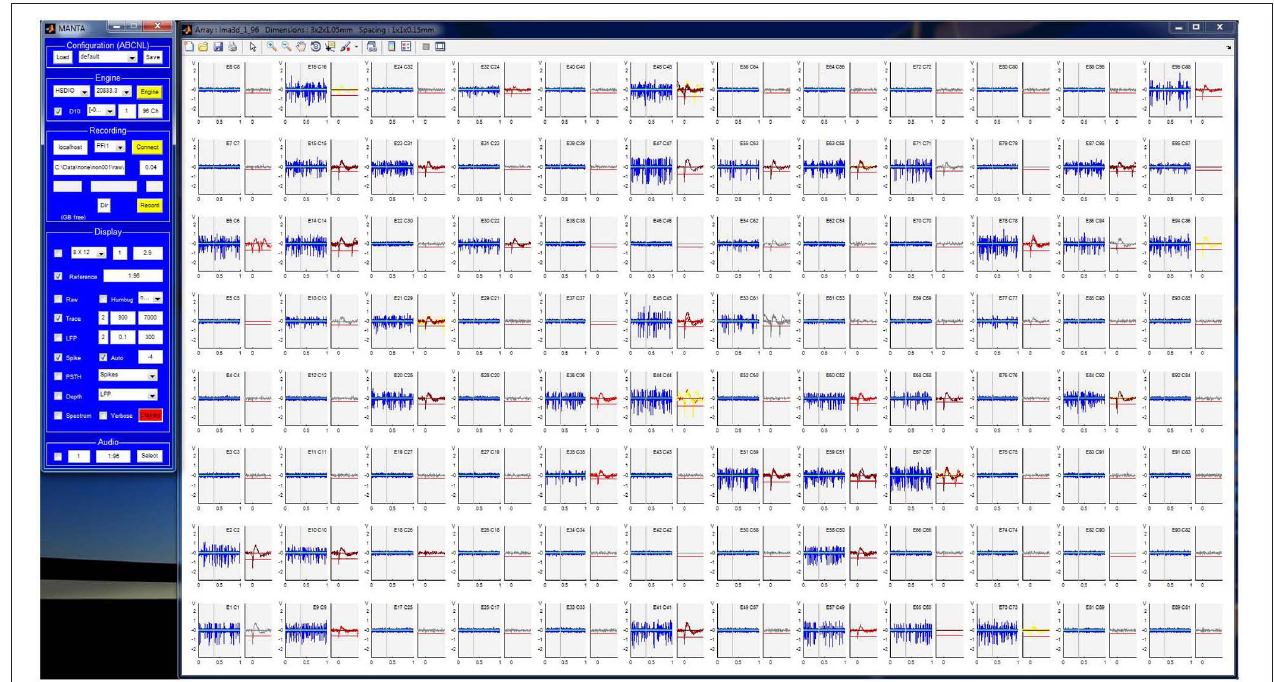
be magnified together (mouse wheel) or individually (clicking below/above 0). Individual plots can be detached for closer inspection and marked for different criteria. While multiple arrays are currently mapped into one window, the possibility to display multiple arrays in separate windows is under